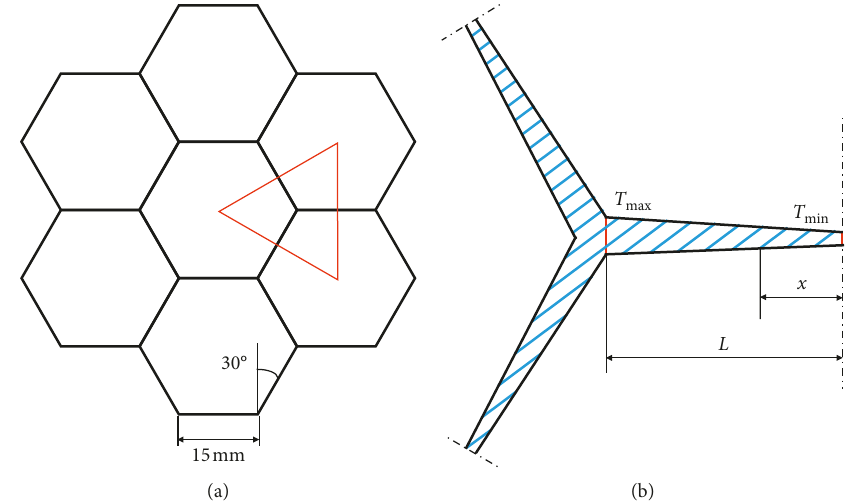
Figure 2: Cross section of a functionally graded thickness honeycomb.